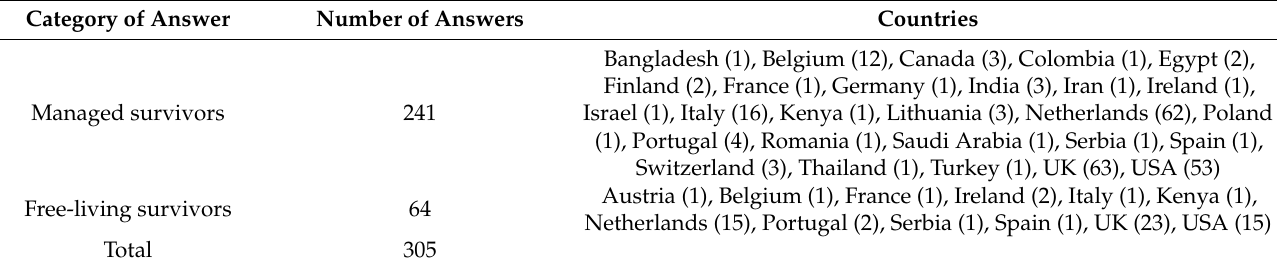
Figure 2. Global reach of the COLOSS Survivors Task Force online survey on possible cases of honey bee, Apis mellifera , colonies that, in an apiary or free-living, are surviving Varroa destructor mite infestations in the absence of chemical treatments. Regions indicated by respondents are highlighted with different colors, depending on the type of surviving colonies (managed, only free-living, or both). The majority of reports were submitted from UK, The Netherlands, and USA. Table 1. Number of reports, divided per category, collected by the COLOSS Survivors Task Force survey on putative cases of untreated A. mellifera colonies surviving V. destructor infestation. The country in which these colonies were reported to occur is